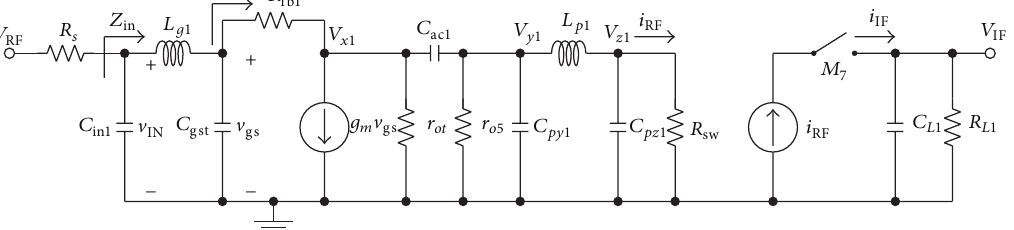
Figure 2: Proposed wideband mixer.